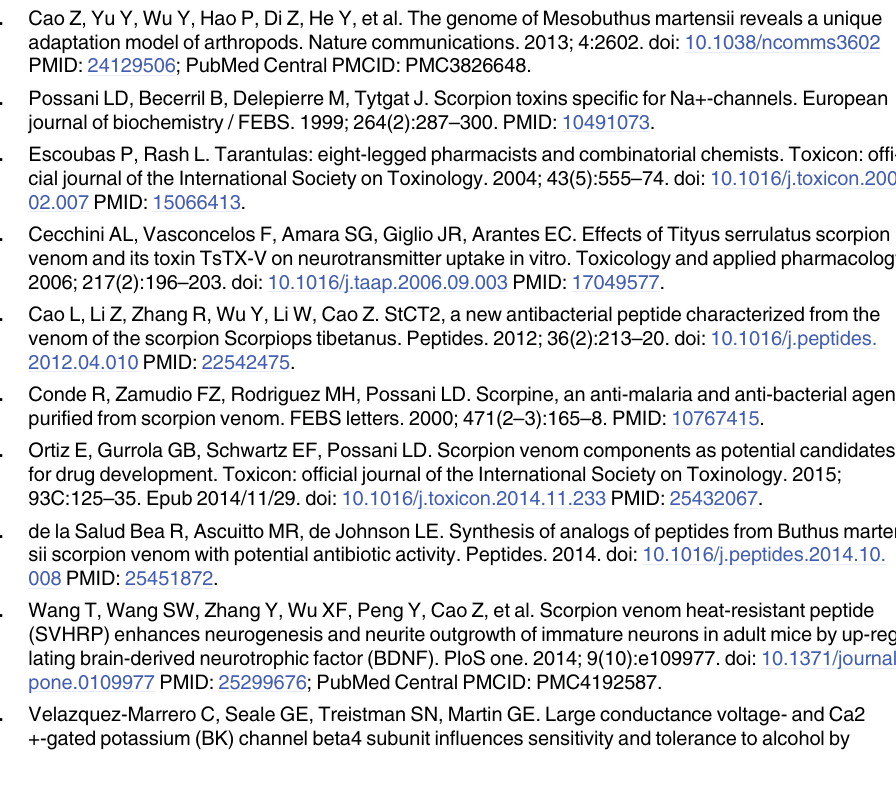
S4 Table. Effects of pET28a-r Bm α TX14 and pET28a-r Bm α TX14 (NEG) on longevity. Life span analysis of empty vector, pET28a-r Bm α TX14 and pET28a-r Bm α TX14 (NEG) were starting from